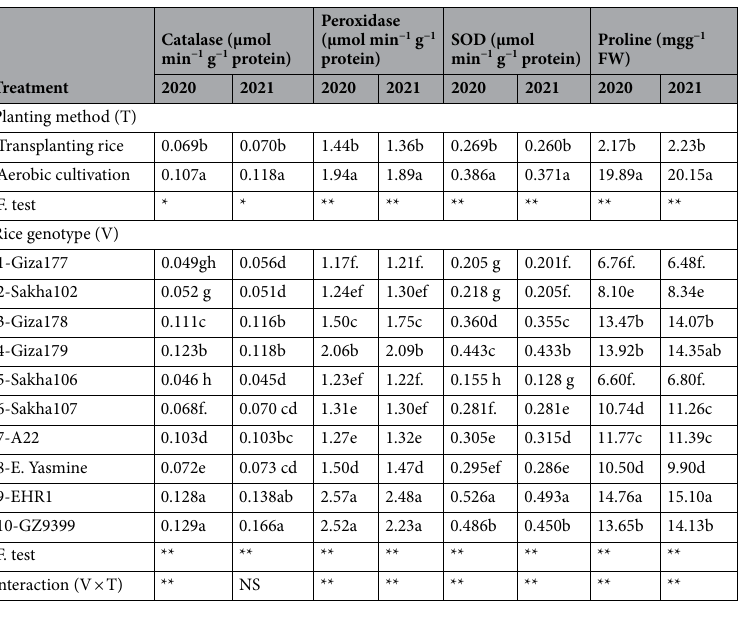
Table 3. Some antioxidants and proline of some rice genotypes affected by the planting methods. Means followed by a common letter at the same column are not significantly different according to Duncan ’ s multiple range at 0.05 levels. *Significant at 0.05 level. **Significant at 0.01 level and NS = Not